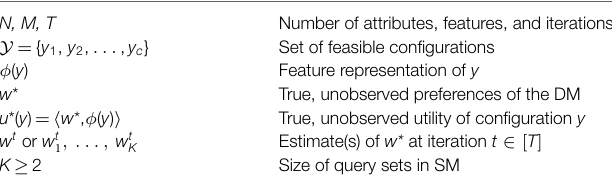
TABLE 1 | Notation used throughout the